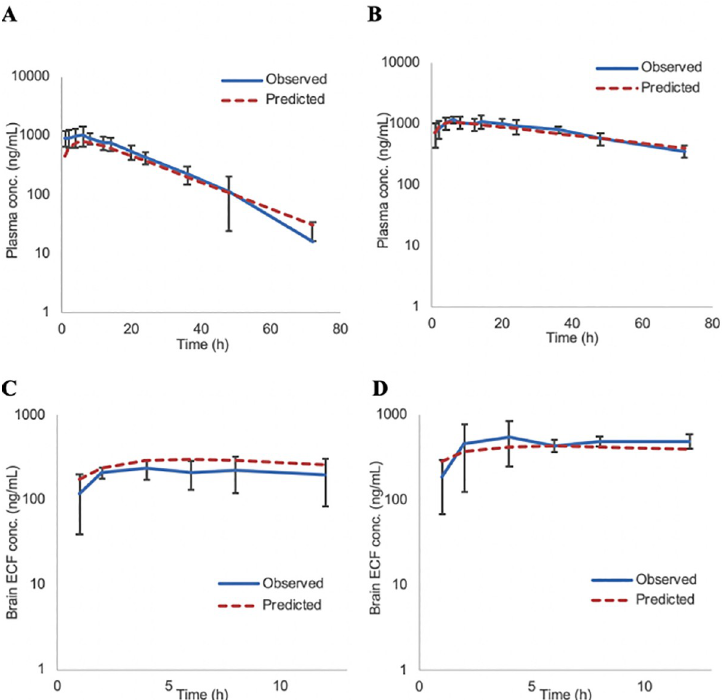
Fig 4. Comparison between the observed vs PBPK model-predicted plasma/ brain ECF concentrations of letrozole in male (A, C) and female (B, D) rats. The brain tissue concentrations were simulated following a single dose of 4 mg/kg using the multi-compartment model as implemented in the Simcyp v17 animal simulator and the ECF concentrations were estimated using f u , brain of 0.58. Observed data; mean ± SD; the solid and dashed lines represent overall mean concentration–time profiles for the observed and predicted data